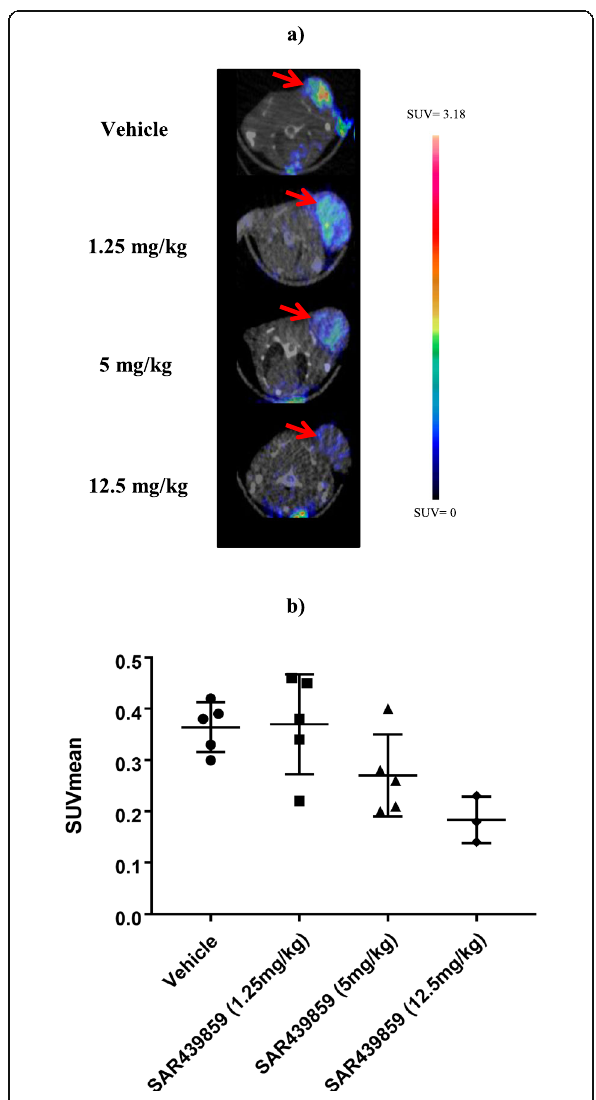
Fig. 1 a Representative co-registered axial FES-PET/CT images in vehicle- or SAR439859-treated mice (the red arrow indicates tumor). b Quantitative analysis of FES-PET signal showing a dose-dependent reduction 4 h after a single administration of SAR439859; the data are expressed as SUVmean (mean ±